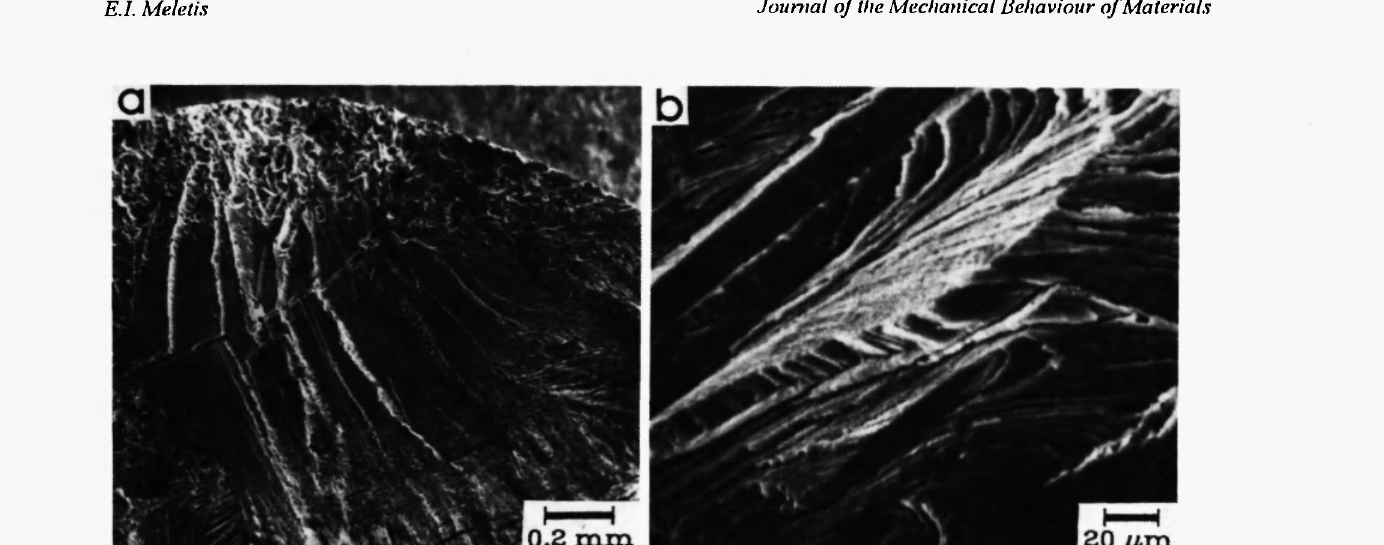
Fig. 1 Typical T-SCC fracture surfaces in (a) 304 stainless steel and (b) α-brass